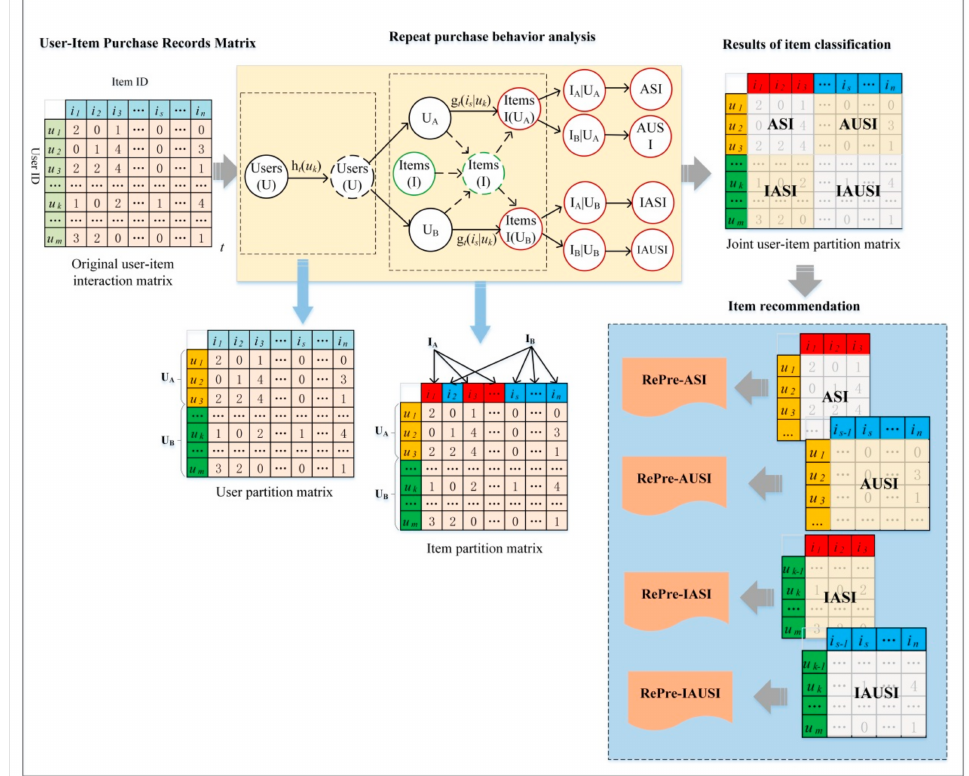
Figure 1. The overall structure of the proposed ReRec